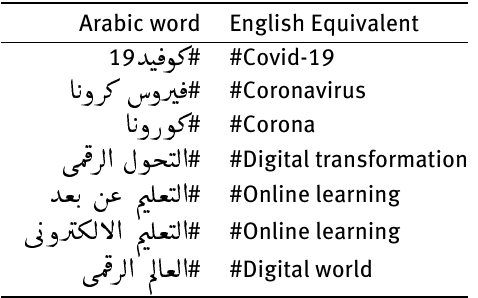
Table 1: Keywords for dataset